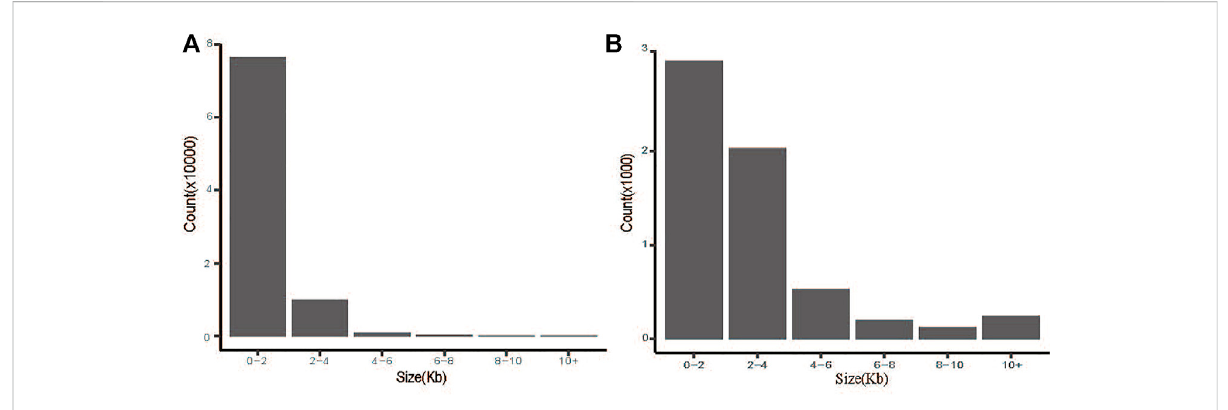
FIGURE 1 Size distribution of CNVs (A) and CNVRs (B) in Tibetan